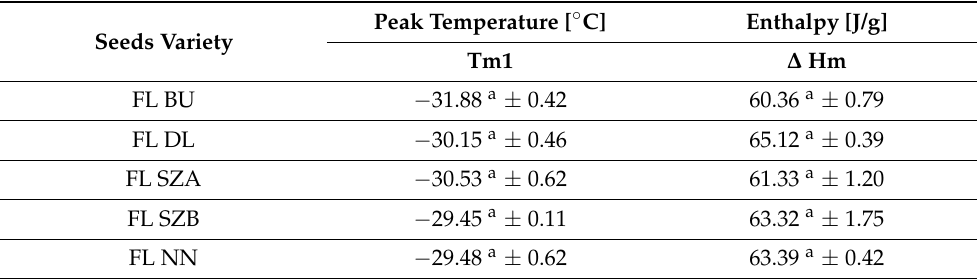
Table 6. DSC thermodynamic parameters of melting process of different cultivars of cold-pressed flaxseed oils obtained by a scanning rate of 5 ◦ C/min. Peak Temperature [ ◦ C] Enthalpy [J/g] Seeds Variety Tm1 ∆ Hm FL BU − 31.88 a ±